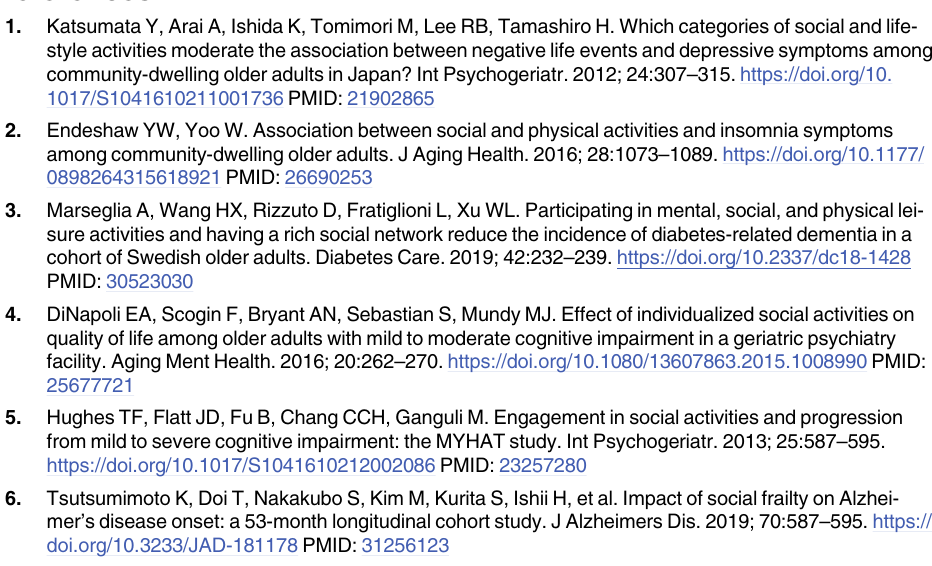
S2 Fig. Coefficient ( β ) and significance for each variable in Model IV with a dependent var- iable of KCL total